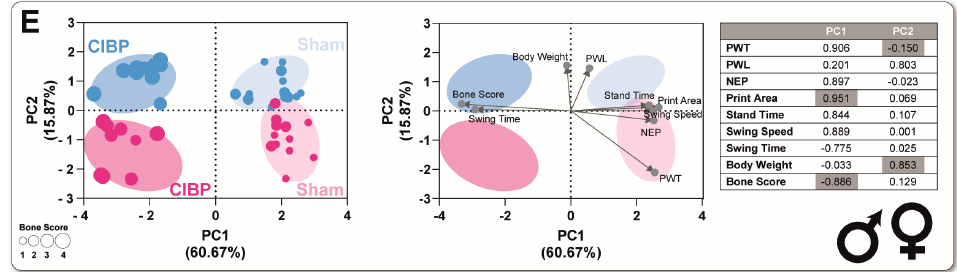
Figure 3. Cancer-induced bone destruction is associated with pain-related behavior. ( A ) Bone morphology was determined by post-mortem scoring of micro-computed tomography imaging ( µ CT) images from the ipsi- and contralateral tibiae. Scale bar = 5 mm ( B ) Scoring of the bone destruction of the ipsilateral side. In both female and male CIBP rats, a significantly increased bone score was detected, indicating increased bone destruction of the ipsilateral tibia. ( C , D ) PCA- assisted phenotyping showed significant group segregation of CIBP from control groups in both sexes, which was significantly triggered by the increased bone score and gait analysis parameters (see PCA loadings). ( E ) Including sex as a biological variable, the CIBP and sham control groups were segregated in both sexes based on PC1 axes (as in ( C , D )). Sex segregation was determined by the significant PC2 loadings, body weight, and heat hypersensitivity (PWT), independent of the experimental group. Results in ( B ) are expressed as median ± 95%CI. Holm-Sidak’s multiple comparison tests followed two-way ANOVA. * for comparison to sham; p -values: *** ≤ 0.001. # for comparison to naive. p -values: ### ≤ 0.001. The PC components were selected to determine the eigenvalues. MANOVA was used for cluster analysis in